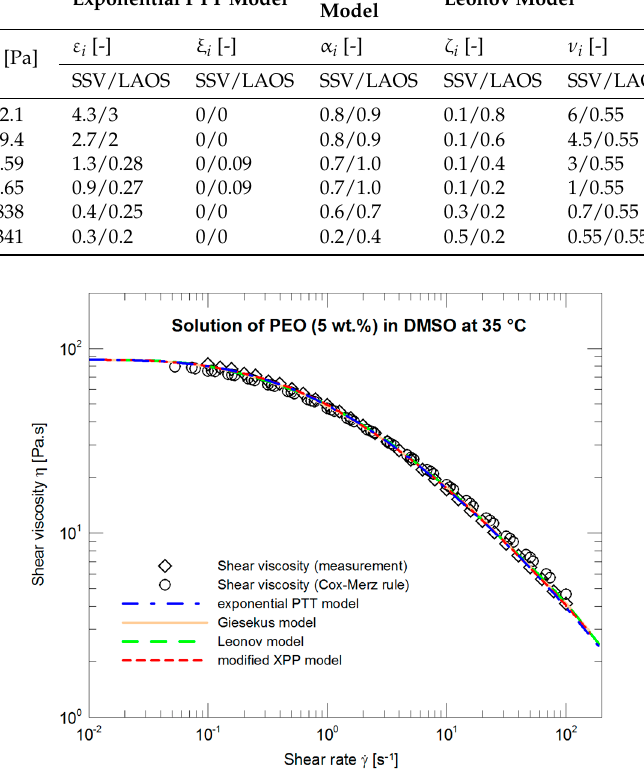
Figure 4. Optimization of the exponential PTT, Giesekus, Leonov, and modified XPP models with respect to the measured steady shear viscosity data.